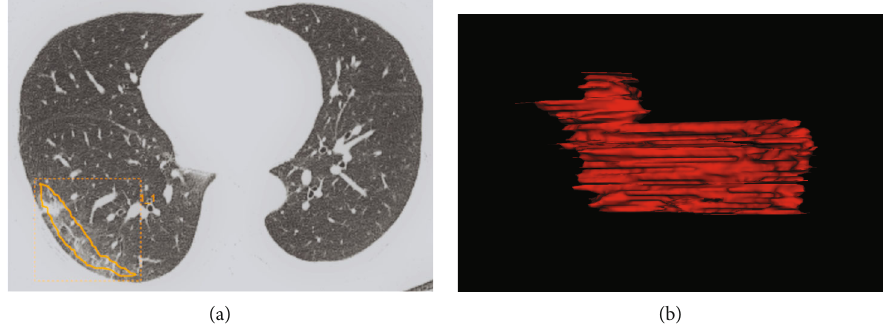
Figure 4: A case of con fi rmed COVID-19 of the resorption stage. A 63-year-old male presented with a 15-day history of fever and cough. (a). CT imaging revealed pure GGO with reticular distributed in the right lower lobe. The area of the lesions was delineated on the axial. (b) The reconstructed images.